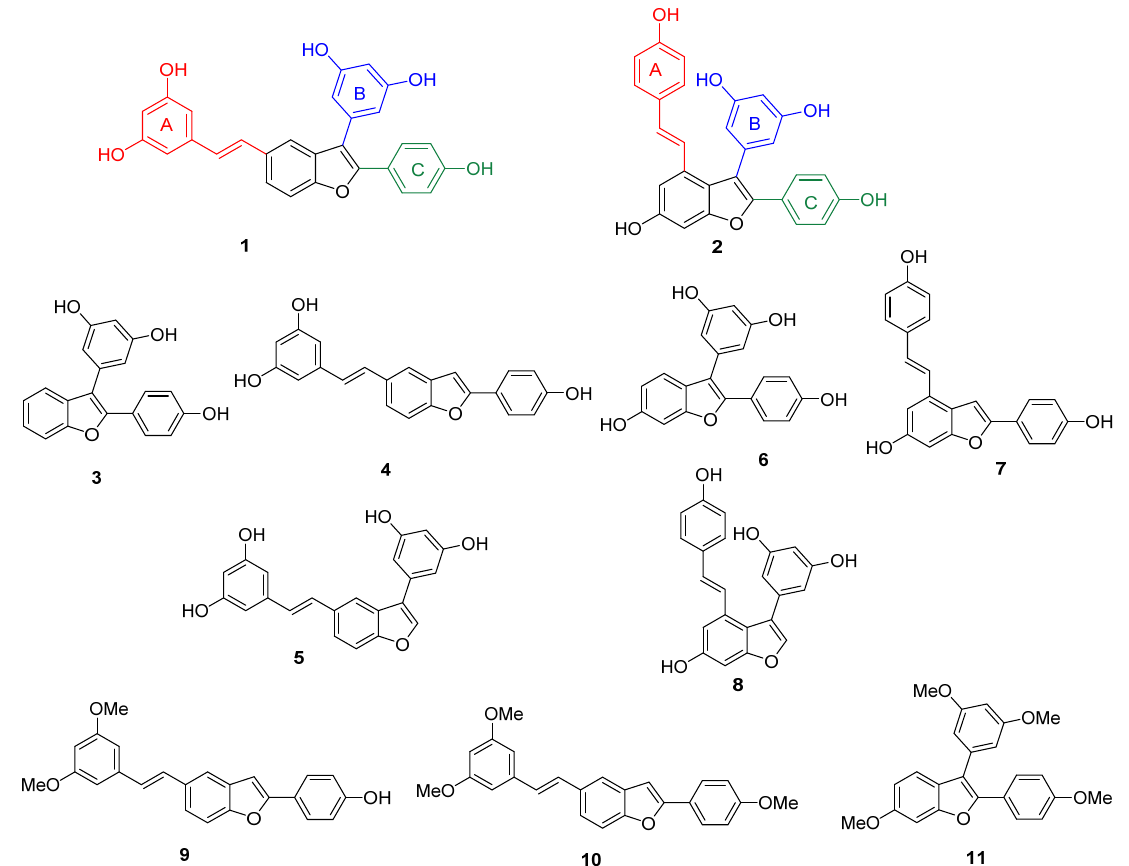
Figure 2. Structures of compounds 1 and 2 and of the simplified analogues 3 – 8 and 9 – 11 .